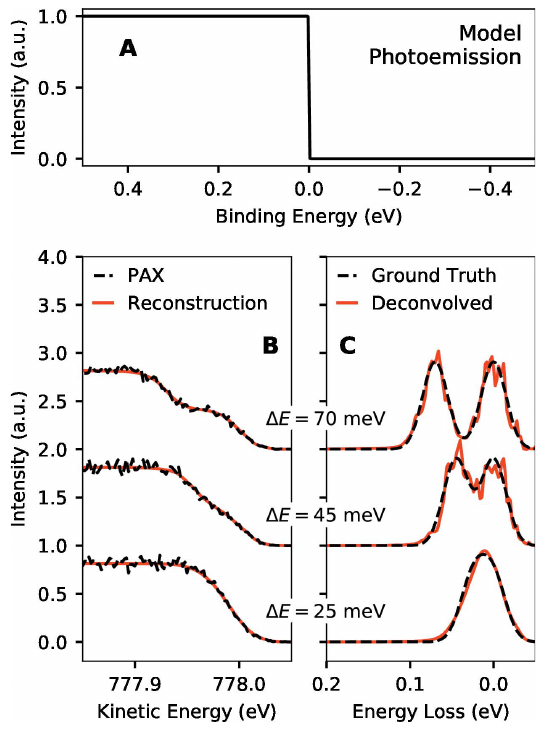
Figure 11 Simulated performance of PAX using a sharp Fermi edge photoemission converter in estimating model doublet RIXS spectra with different peak separations ( (cid:2) E ). For each case, (cid:2) 10 5 electrons were simulated to be detected from photoemission within 0.4 eV of the Fermi level. The doublets consisted of two Gaussian peaks with 100 meV FWHM each and variable peak separation. The shape of the Fermi edge was determined by a Fermi–Dirac distribution at 4 K (boiling point of helium). (A) Model Fermi edge photoemission spectrum for a metal at 4 K (boiling point of helium). (B) Simulated PAX data (black) as well as the reconstruction of that data from the deconvolved results as a function of the peak separation in the doublet ( (cid:2) E ). (C) RIXS spectra estimated through deconvolution of the simulated PAX data and corresponding ground truth